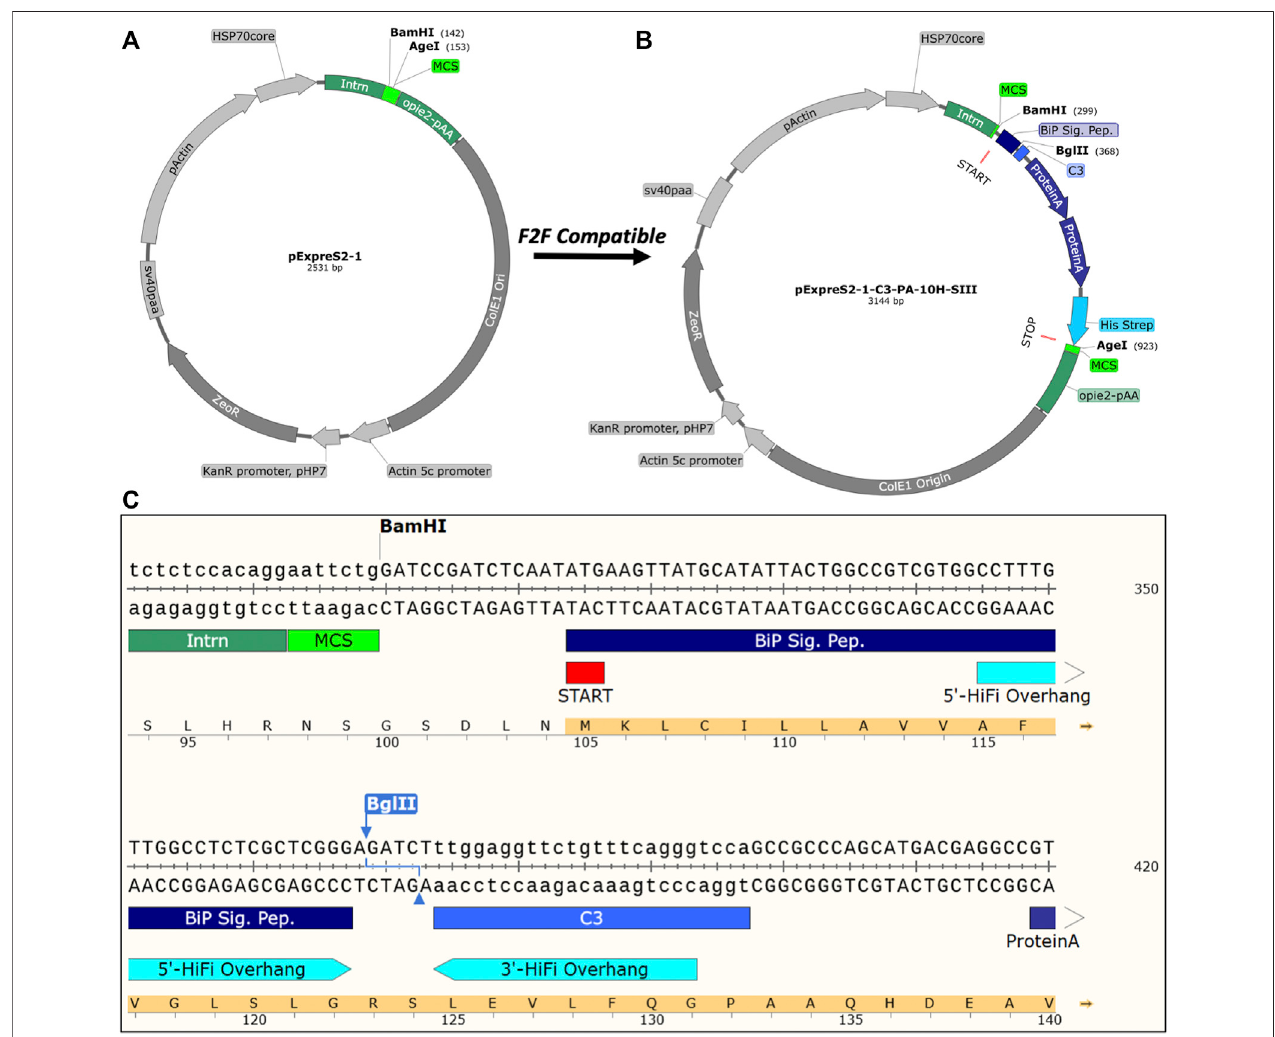
FIGURE 2 | Vectors and construct design. (A) pExpreS 2 -1 vector backbone included in the ExpreS 2 ion ’ s commercially available kit. (B) Exemplar F2F vector, pExpreS 2 -1-C3-PA-10H-SIII, modi fi ed for high-throughput structural applications. (C) Sequence-level details of pExpreS 2 -1-C3-PA-10H-SIII showing the BglII linearizationsequence,recommendedHiFioverhangs,N-terminalsecretionpeptide,andC-terminalaf fi nitytags.AnoverviewofallF2Fvectorscreatedforthisstudycan be found in Table 1 .